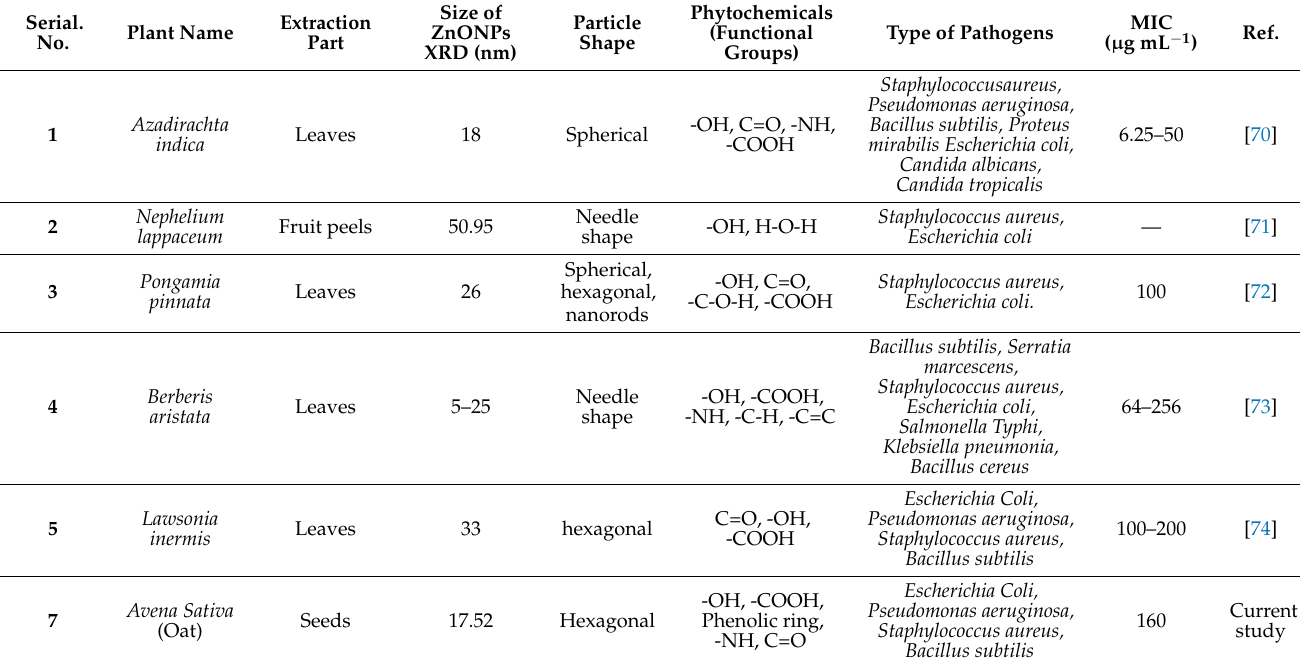
Figure 10. SEM images using 15 kV and magnifications ×24,000 and ×20,000, (A) P . aeruoginosa and (B) E. coli : ( a , d ) control; ( b , e ) cells treated with oat biomass; and ( c , f ) cells treated with ZnONPs and changes in shape. Table 3. Comparative study of biosynthesis of ZnONPs using various plant